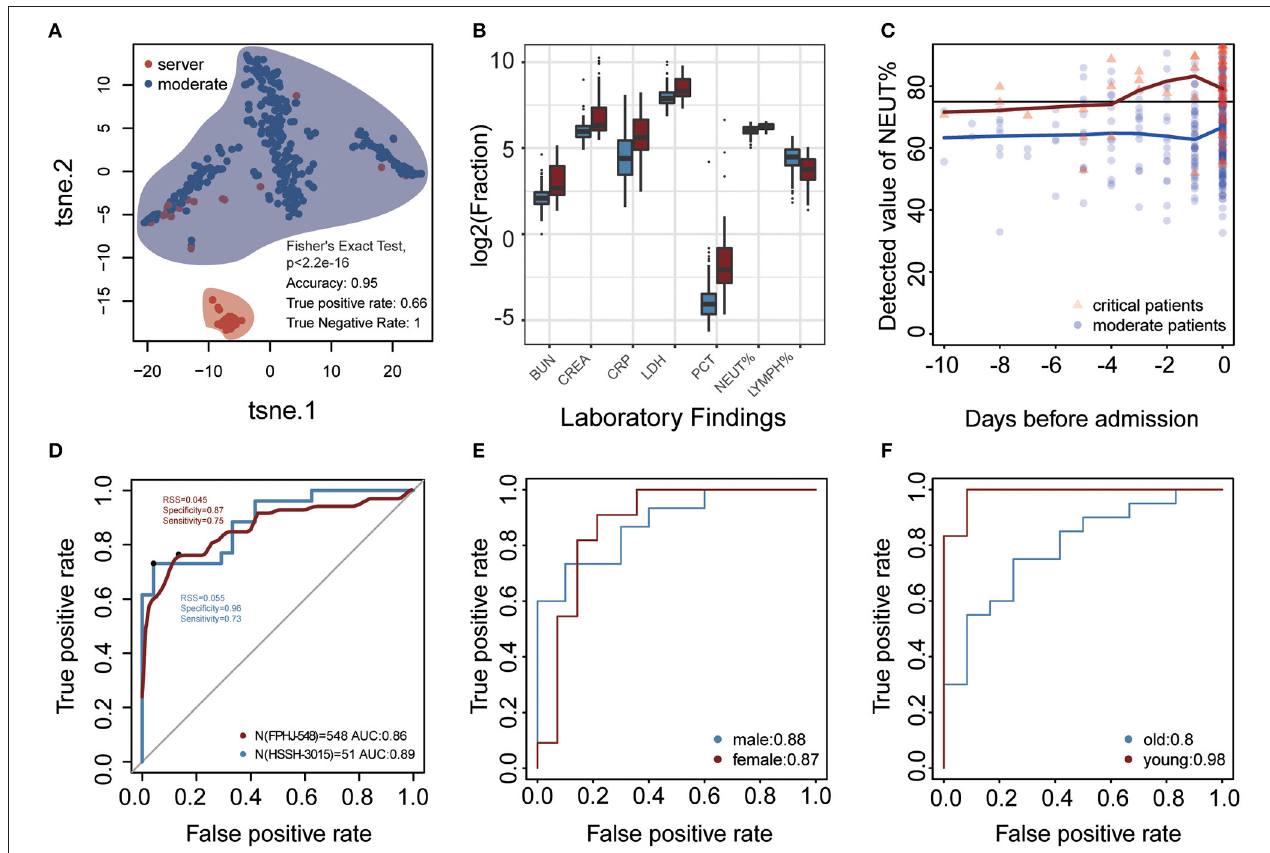
FIGURE 3 | Laboratory findings for predicting progression of COVID-19 at admission. (A) t-SNE was performed on 329 moderate COVID-19 patients and 56 severe COVID-19 patients based on 40 laboratory findings (FPHJ-548 dataset). The red represents the severe patients and the blue represents moderate patients. (B) The difference of representative clinical markers between moderate and severe patients in the FPHJ-548 dataset. The red represents the severe patients and the blue represents the moderate patients. (C) The change of neutrophils percentage during the period before admission. The black line is the maximum reference value. The blue dot represents moderate patients and the red triangle represents severe patients. (D) The ability of the model to distinguish severe from moderate patients based on 4 laboratory findings at admission. The x-axis is specificity and the y-axis represents sensitivity. The red solid line represents the mean of the 5-fold cross-validation. The blue represents the AUC of HSSH-3015. (E,F) The ability of the model in patients of different sex and